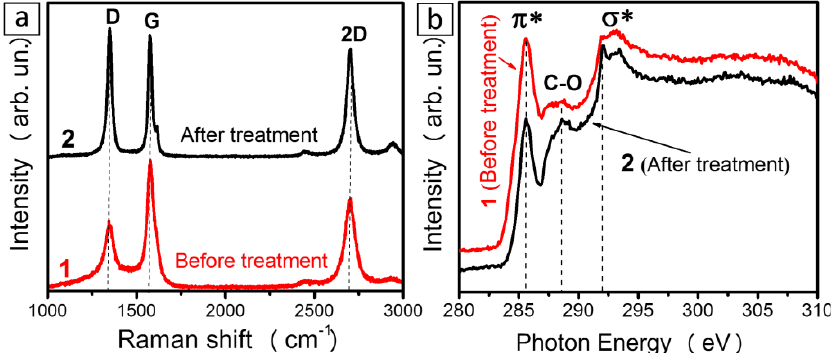
Figure 5. Raman spectra ( a ) and near-edge X-ray absorption fine structure (NEXAFS) C K-edge spectra ( b ) of CNT arrays before (1) and after (2) hydrogen plasma treatment.